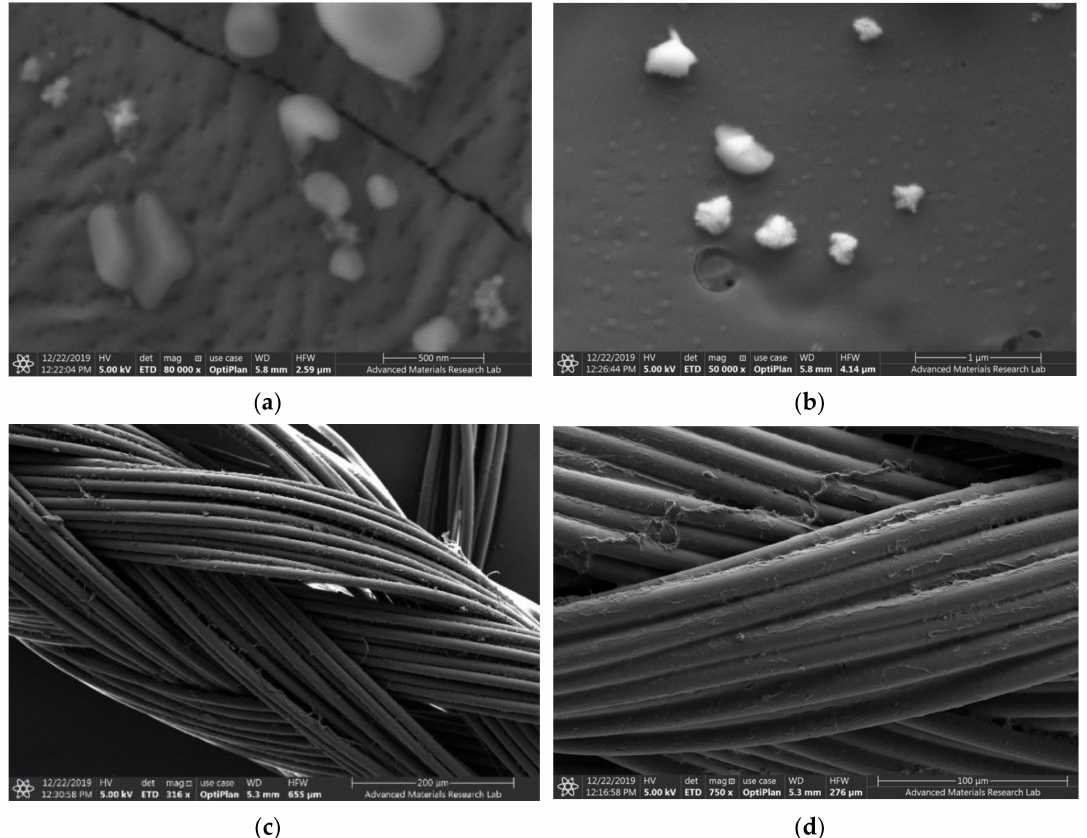
Figure 1. Scanning electron microscopy (SEM) of AV-PVP-I 2 with Aloe vera (AV), polyvinylpyrrolidone (PVP), iodine (I 2 ), and sodium iodide (NaI) and the PGA sutures. From up to down: ( a , b ) AV-PVP-I 2 -NaI; ( c ) Control (plain PGA suture); ( d ) suture coated with AV-PVP-I 2